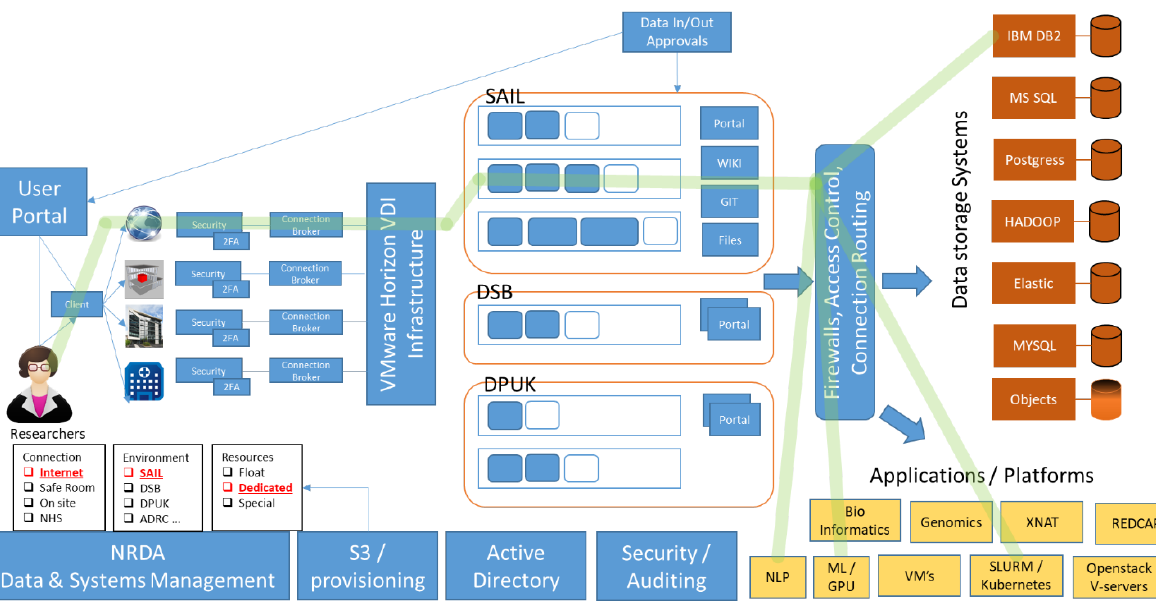
Figure 1: The SAIL Secure Research